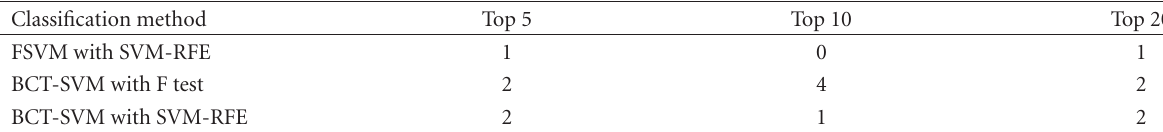
Table 9. Classifiers’ performance on acute leukemia dataset by cross-validation (number of wrong classified samples in leave-one-out